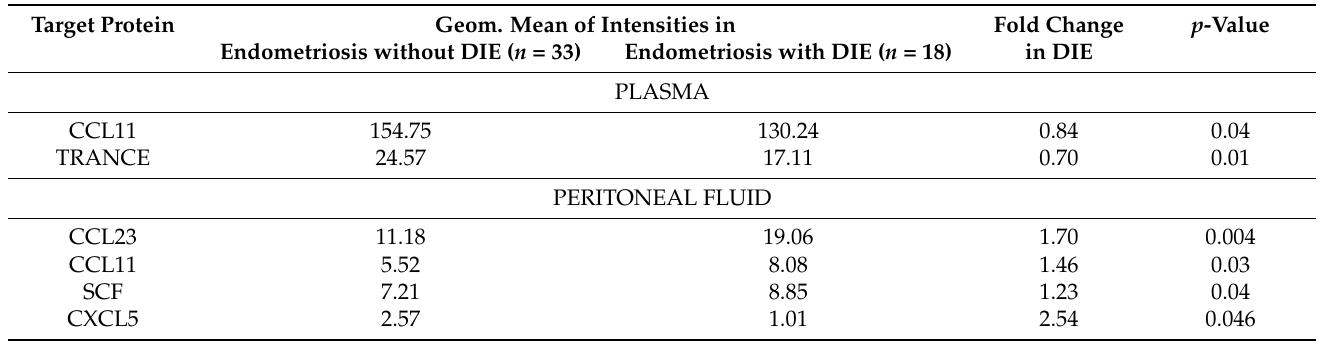
Table 3. Proteins that were significantly increased or decreased in patients with deep-infiltrating endometriosis (DIE) compared to endometriosis patients without DIE.